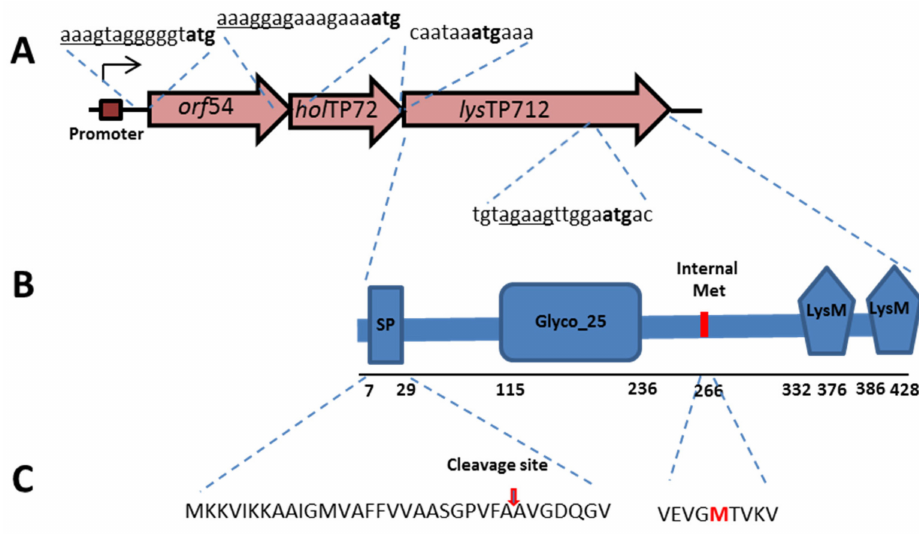
Figure 1. Features of the TP712 lytic cassette (GenBank AAX13238.1). ( A ) The lytic cassette of TP712 contains a gene of unknown function ( orf54 ), a putative holin gene holTP712 ( orf55 ) and the lysin gene lysTP712 ( orf56 ); start codons bold, RBS underlined. ( B ) Protein domains identified in the TP712 endolysin encoding gene and position of a putative internal translational start site (Met). SP, cleavable signal peptide; Glyco_25, glycosyl hydrolase catalytic domain, and two LysM cell binding domains. ( C ) N-terminal signal peptide amino acid sequence. Cleavage-site is indicated by an